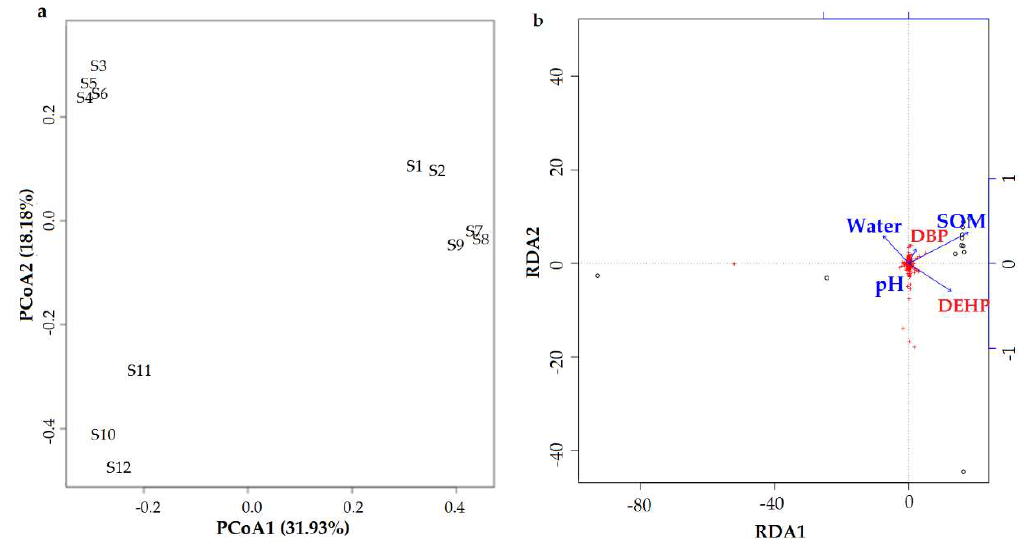
Figure 4. ( a ) PCoA (principal coordinate analysis) of bacterial OTUs (Operational Taxonomic Units) at the 97% level based on the Bray–Curtis distance in different treatments and ( b ) redundancy analysis (RDA) of different treatments in terms of three environmental factors.